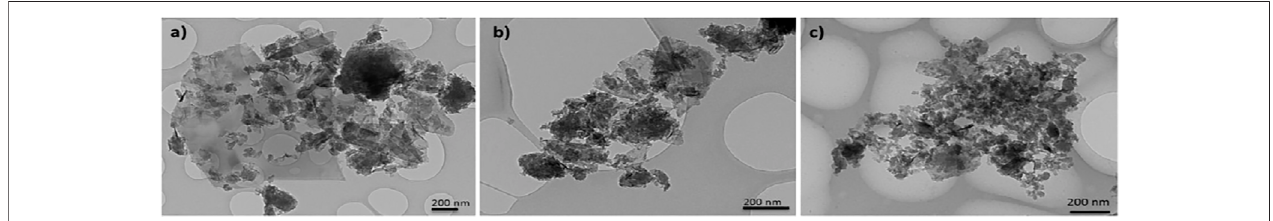
FIGURE 1 | TEM images of (A) NP1, (B) NP2, and (C) NP3, showing their